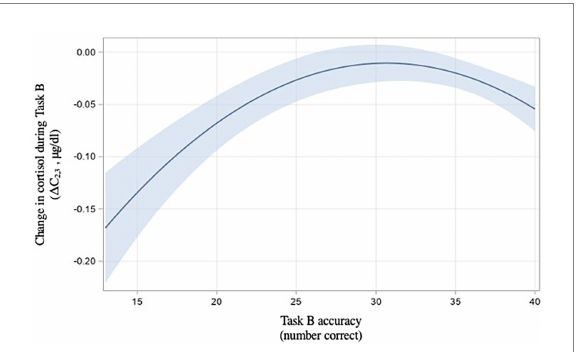
FIGURE 6 Relationship between Task B performance and cortisol (H3) with 95% confidence intervals with 95% confidence